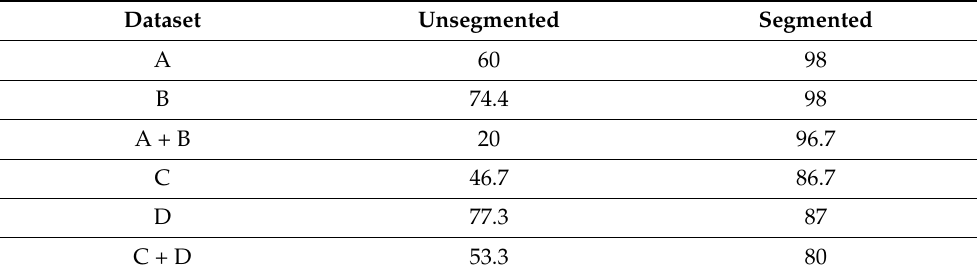
Table 5. Percentage accuracy of classification for segmented and unsegmented datasets.